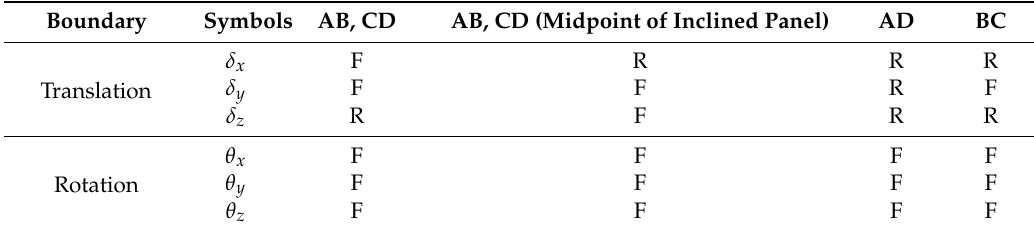
Table 2. Boundary conditions of the PCCSW (Note: R: Restrained, F: